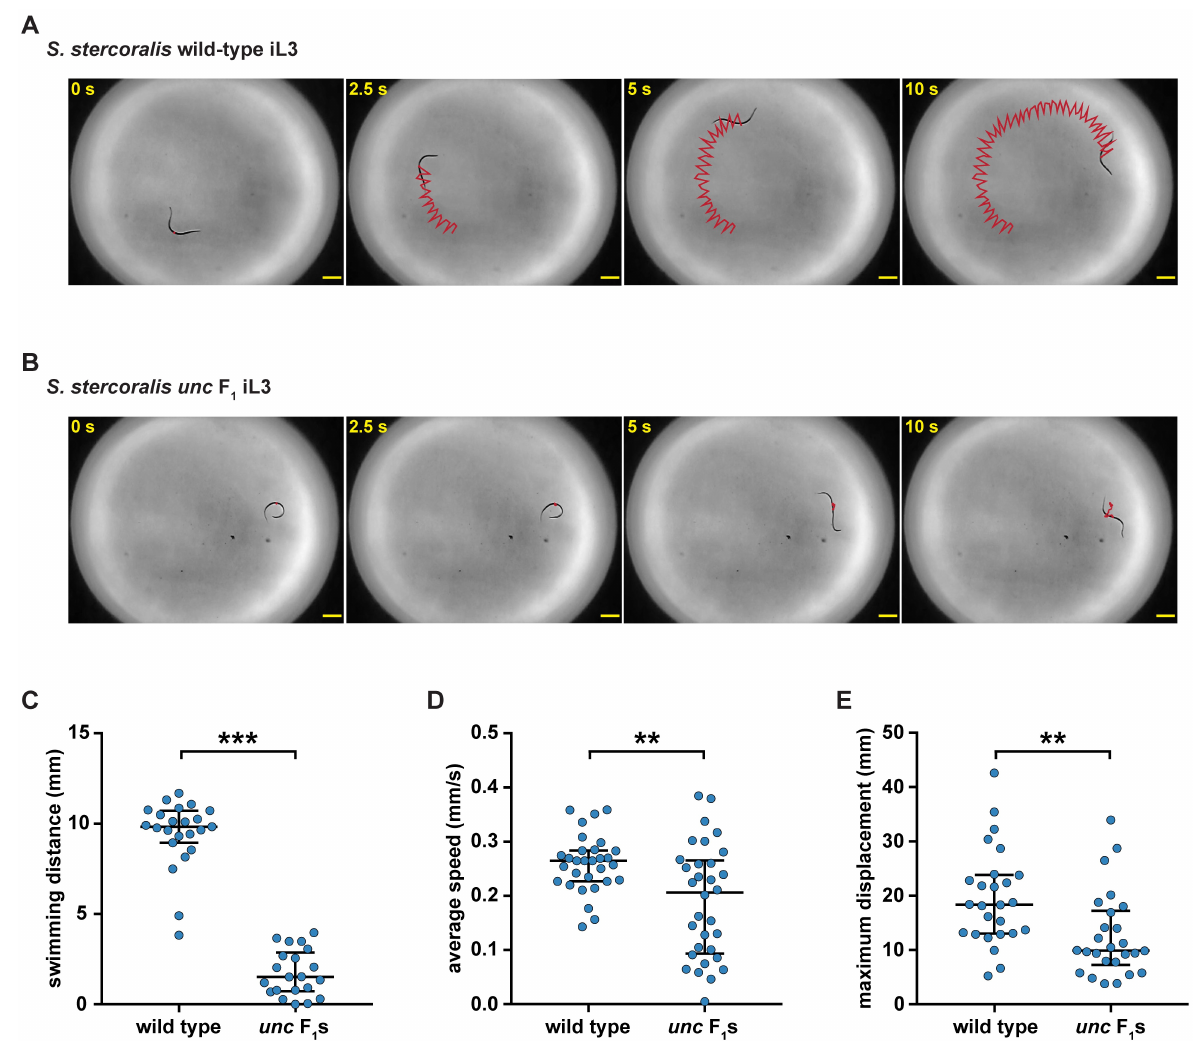
Fig 2. CRISPR-Cas9 targeting of the Ss-unc-22 gene results in iL3s with an uncoordinated phenotype. ( A-B ) Time-lapse images of wild-typeiL3s ( A ) vs. unc F 1 iL3s ( B ) swimmingin a water droplet. Wild-type iL3s showedcontinuous rapid movement in water; unc F 1 iL3s experienced intermittent bouts of twitching, paralysis,and uncoordinated movement. For A and B , red lines indicateiL3 trajectories. Scale bars = 200 μ m. ( C ) Swimmingdistancefor wild-typeiL3s vs. unc F 1 iL3s over a 10-s period. unc F 1 iL3s swam shorter distances relative to wild-typeiL3s. *** P < 0.001, Mann-Whitney test. n = 21–23 trials for each population. ( D ) Average crawlingspeed for wild-type iL3s vs. unc